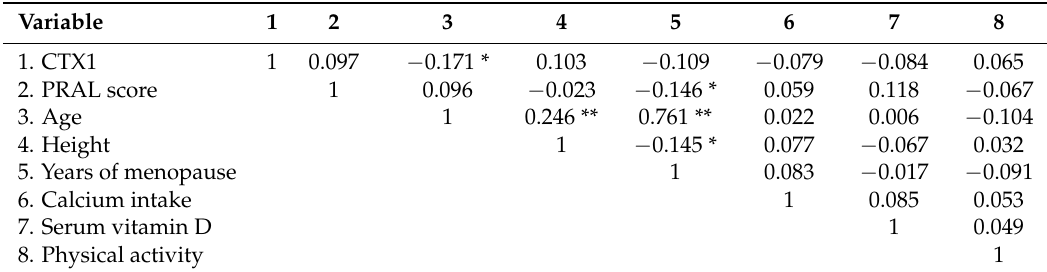
Table 2. Bivariate Pearson correlation coefficients for rate of bone resorption (CTX1), PRAL score and controls.